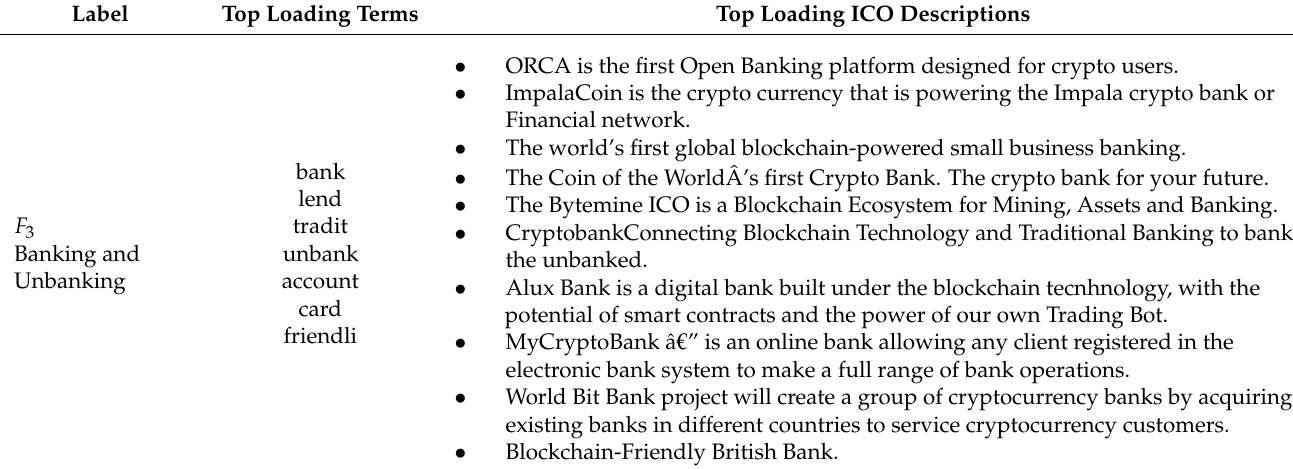
Table A3. Banking and Unbanking.